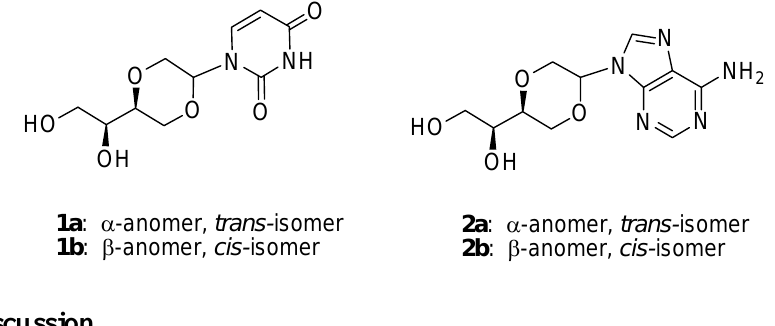
Figure 1. Uridine and adenosine analogs containing a 1,4-dioxane sugar equivalent.